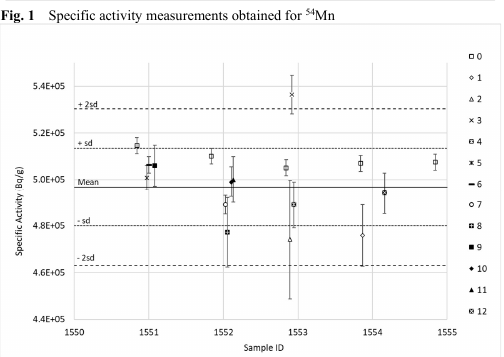
Fig. 1 Specific activity measurements obtained for 54 Mn Fig. 2 S pecific activity measurements obtained for 58 Co